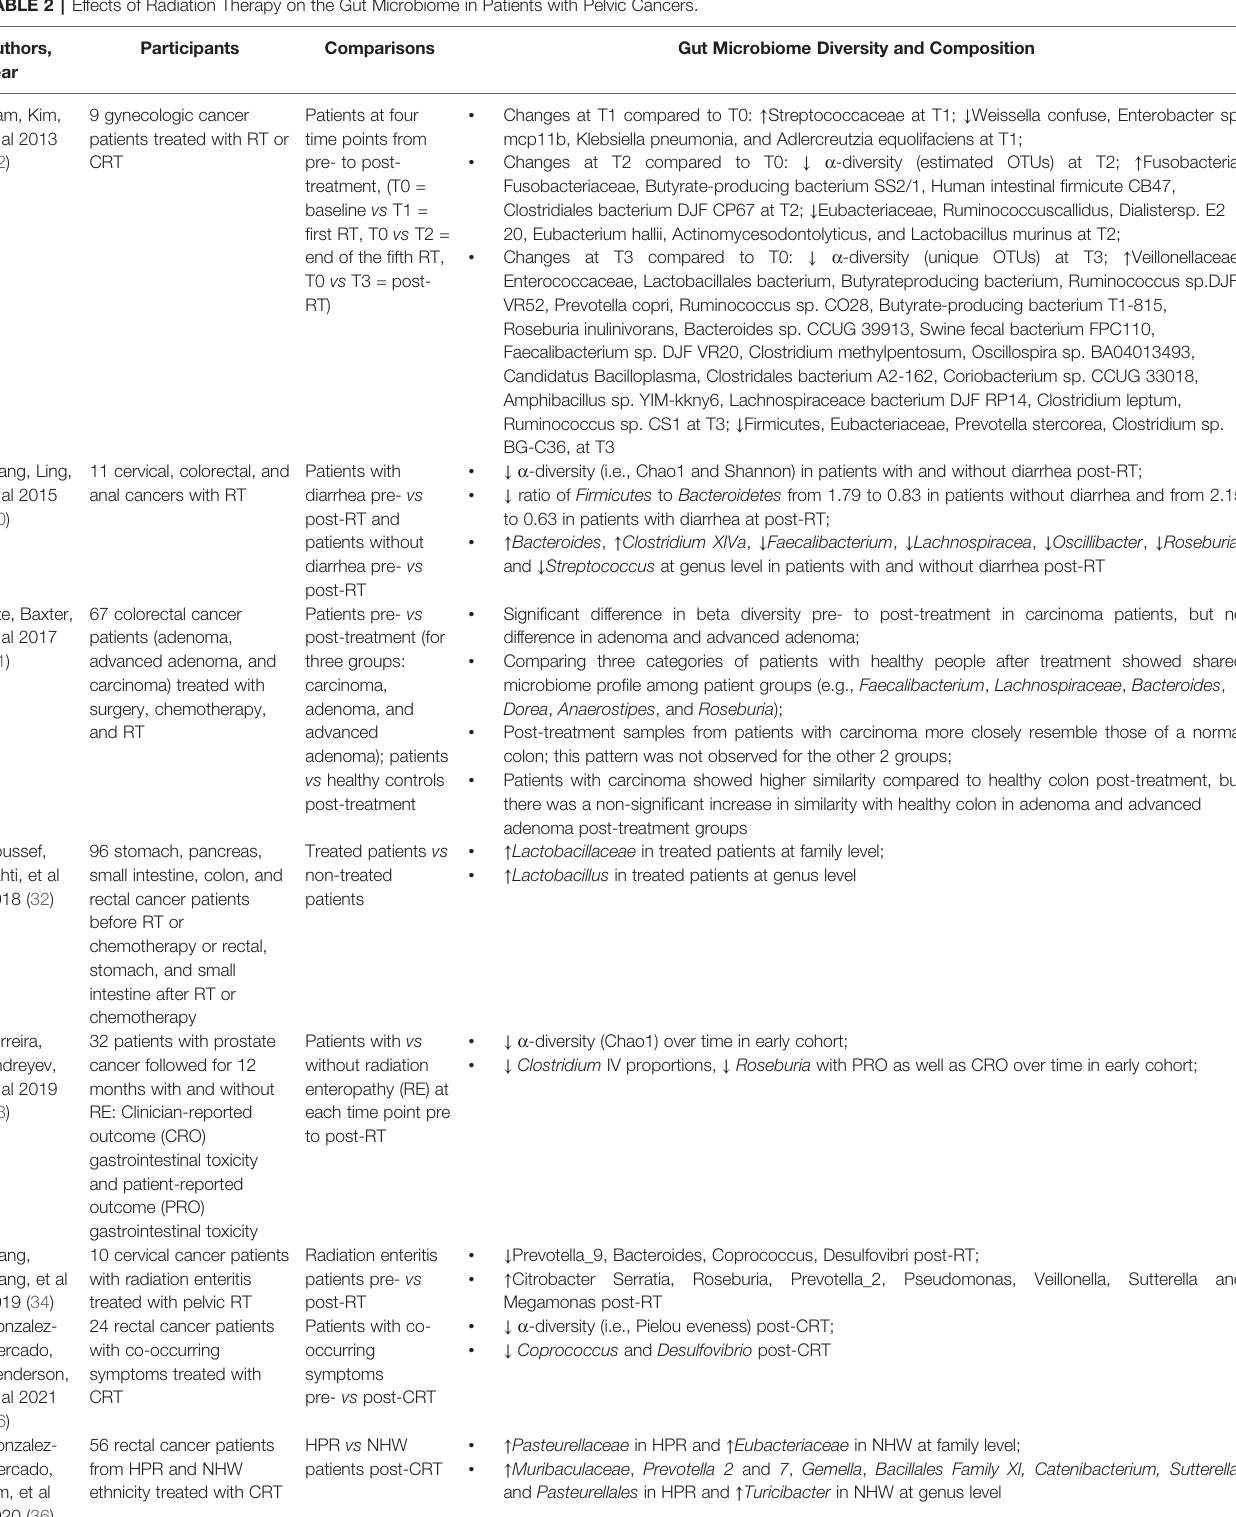
TABLE 2 | Effects of Radiation Therapy on the Gut Microbiome in Patients with Pelvic Cancers. Authors, Participants Comparisons Gut Microbiome Diversity and year